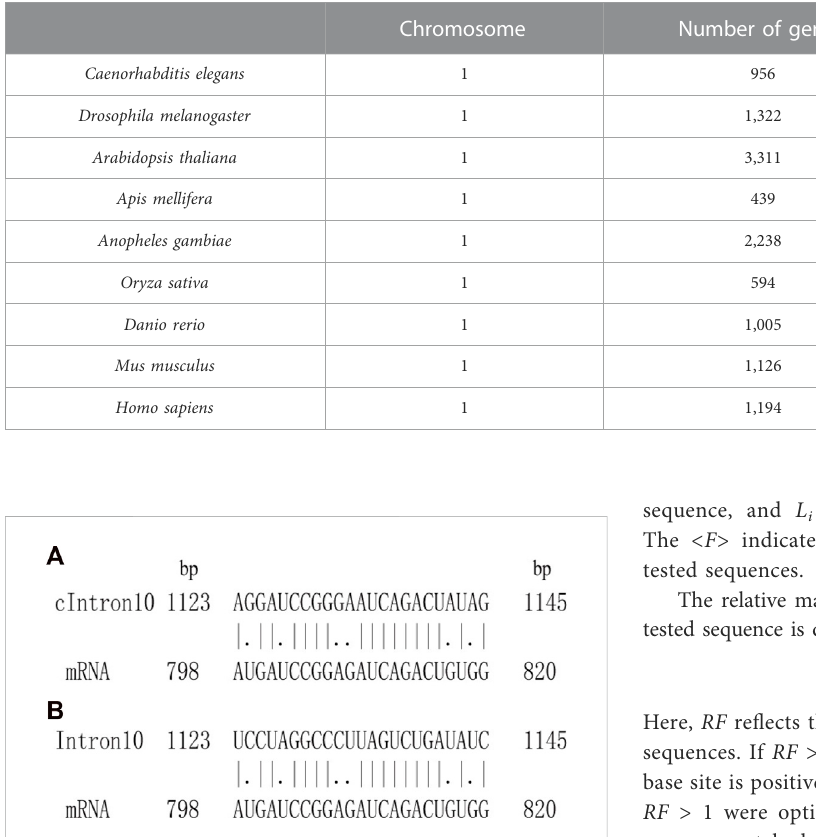
FIGURE 1 Sketch matched map between intron and corresponding CDS. (A) Smith – Waterman local alignment. cIntron10 means the complementary segment of intron 10. (B) Authentic matched